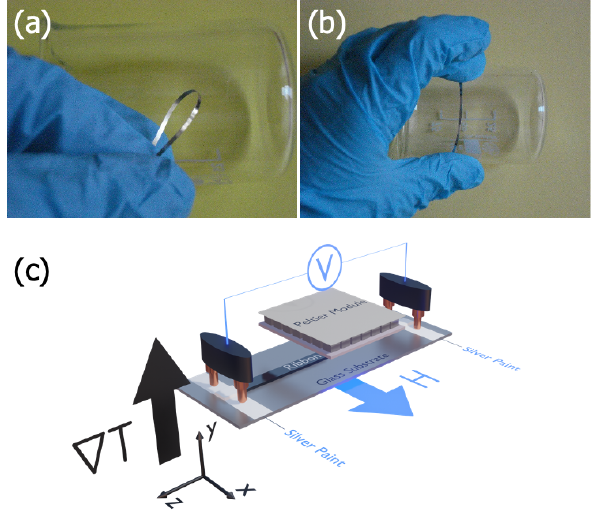
Figure 1. General view of the Fe 3 Co 67 Cr 3 Si 15 B 12 amorphous ribbons of the 45 mm length showing the high degree of flexibility; ( a ) ribbon arranged in a circle ( b ) ribbon placed onto the cylindrical surface of 50 mm in diameter. ( c ) Schematic representation of the experimental setup for Anomalous Nernst Effect measurements. The ribbon was connected to a glass substrate with silver paint cured for 24 h. The Peltier module was responsible for the thermal gradient ( (cid:126) ∇ T ) perpendicular to the ribbon plane. Spring gold contacts were used for the thermomagnetic measurements, while an external magnetic field was generated by an